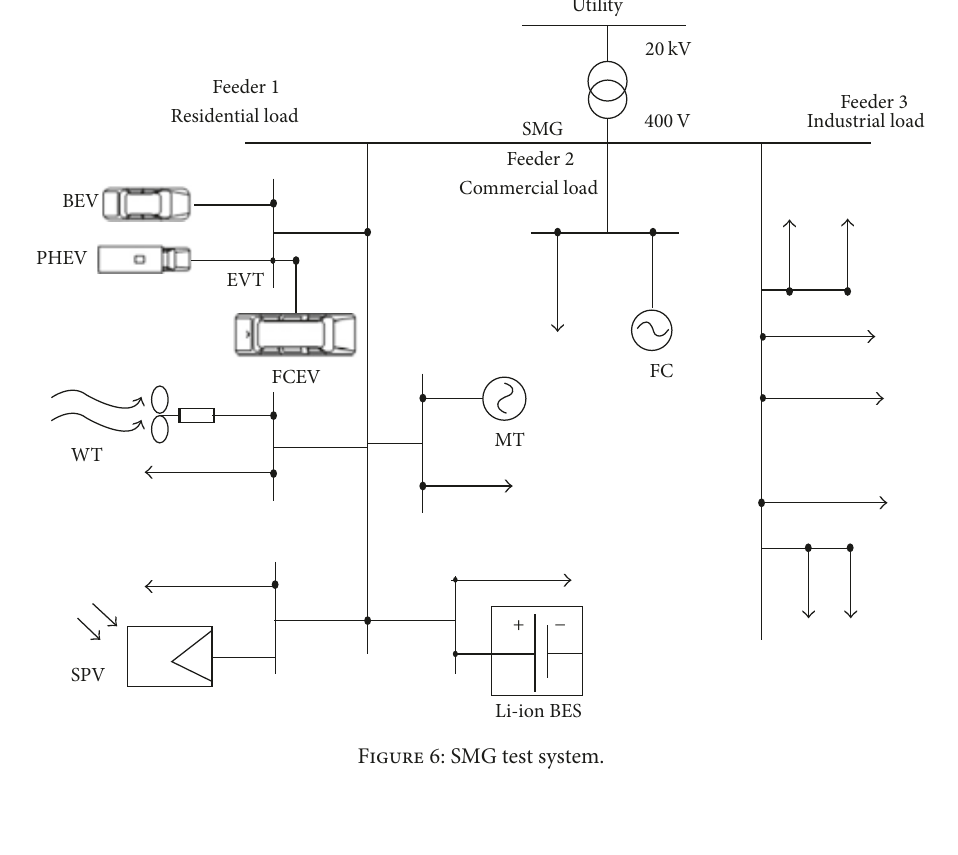
Figure 6: SMG test system.